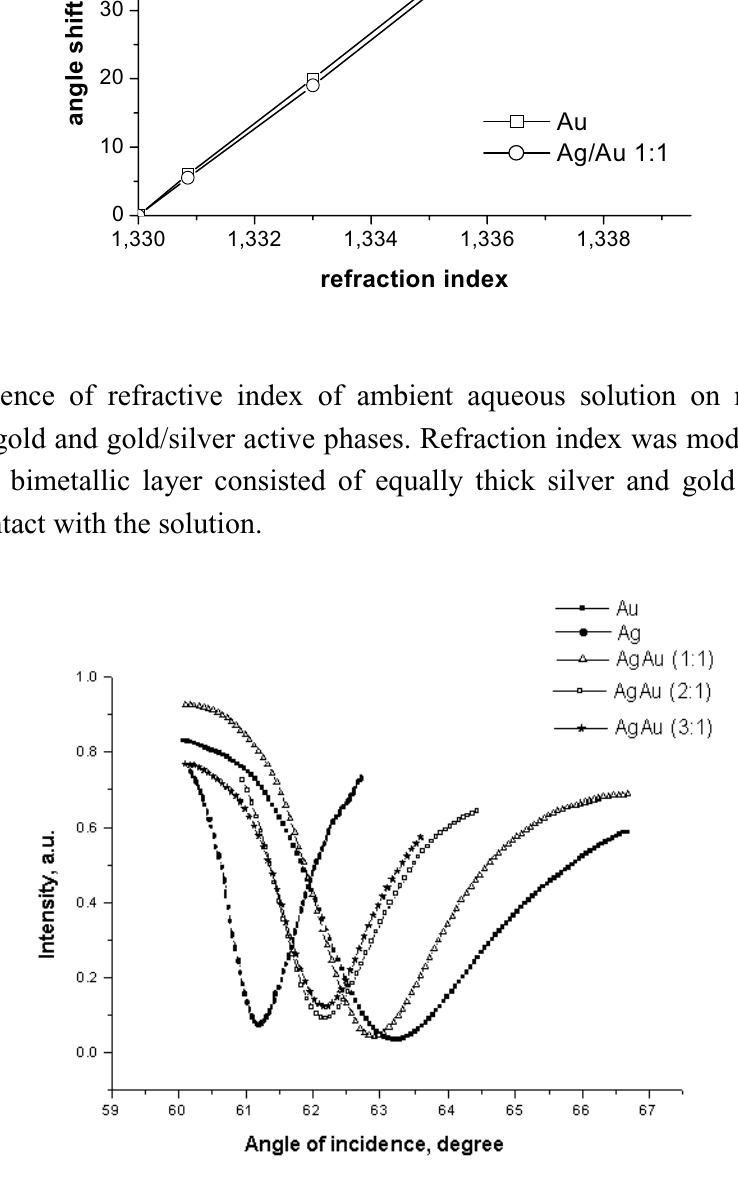
Figure 4. Experimental SPR curves for various (bi)metallic